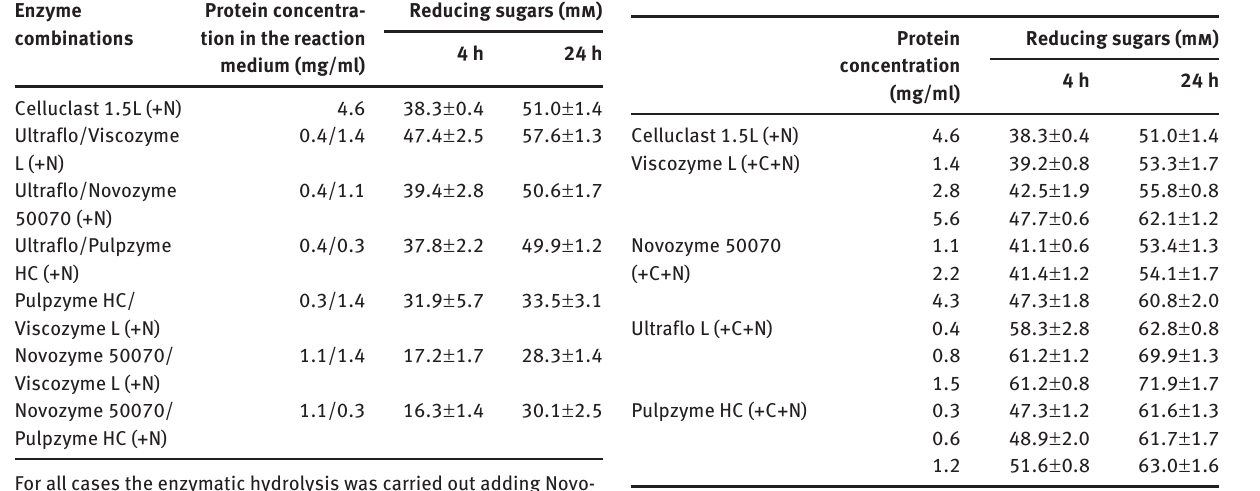
Table 4 Enzymatic saccharification of regenerated corn cob